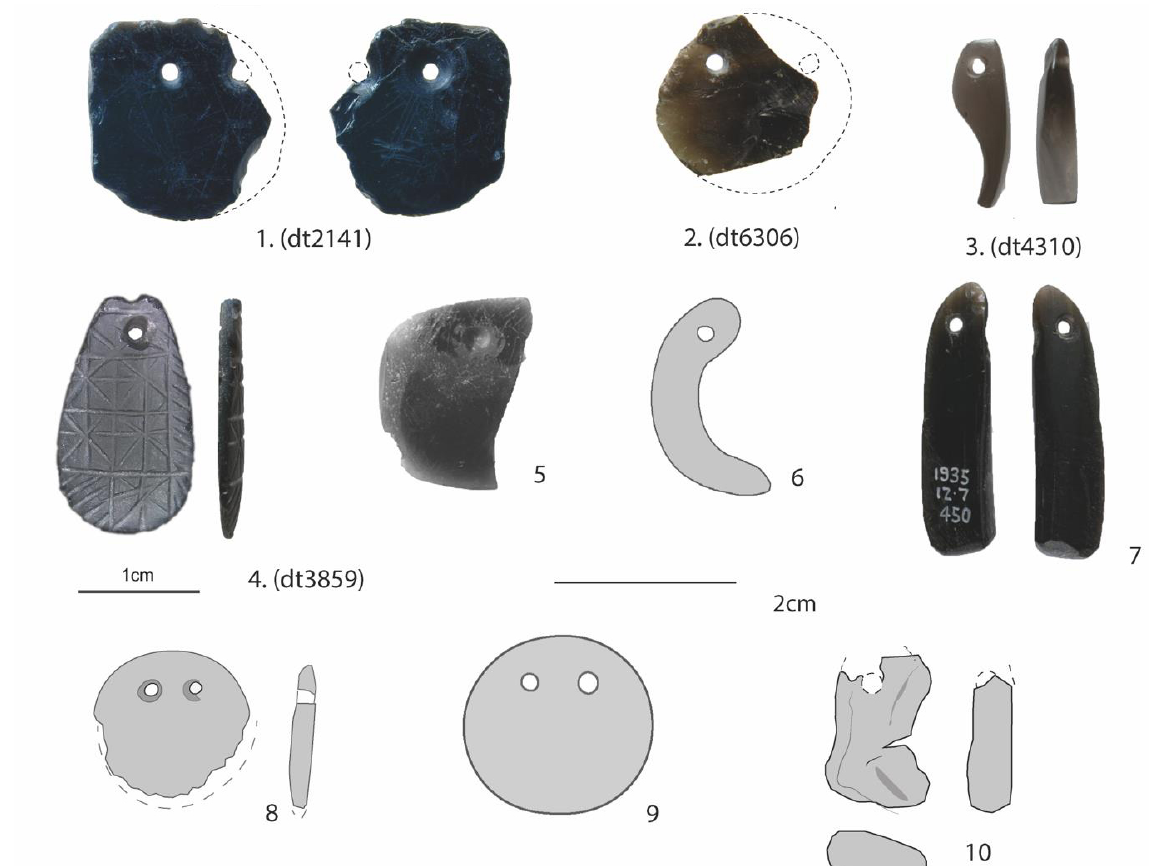
Figure 3. Examples of pendants from Domuztepe (1-5); Tülintepe (6), (redrawn from Oliveira et al . 1983: fig 4, 6); Chagar Bazar (7); Qdeir 1 (8) (PPNB) (redrawn from Cauvin 2000: fig. 7.1.); Ras Shamra VC (9) (redrawn from de Contenson 1972: fig. 125, 11) and Tell Aswad (10) (PPNB) (redrawn from Maréchal 1995: fig. 119, k). Note: No. 4 is a small engraved pendant, broken across the original perforation and the new perforation crudely executed and placed off-centre. No. 5 has an incomplete perforation which suggests on-site manufacture. Photographs courtesy of Stuart